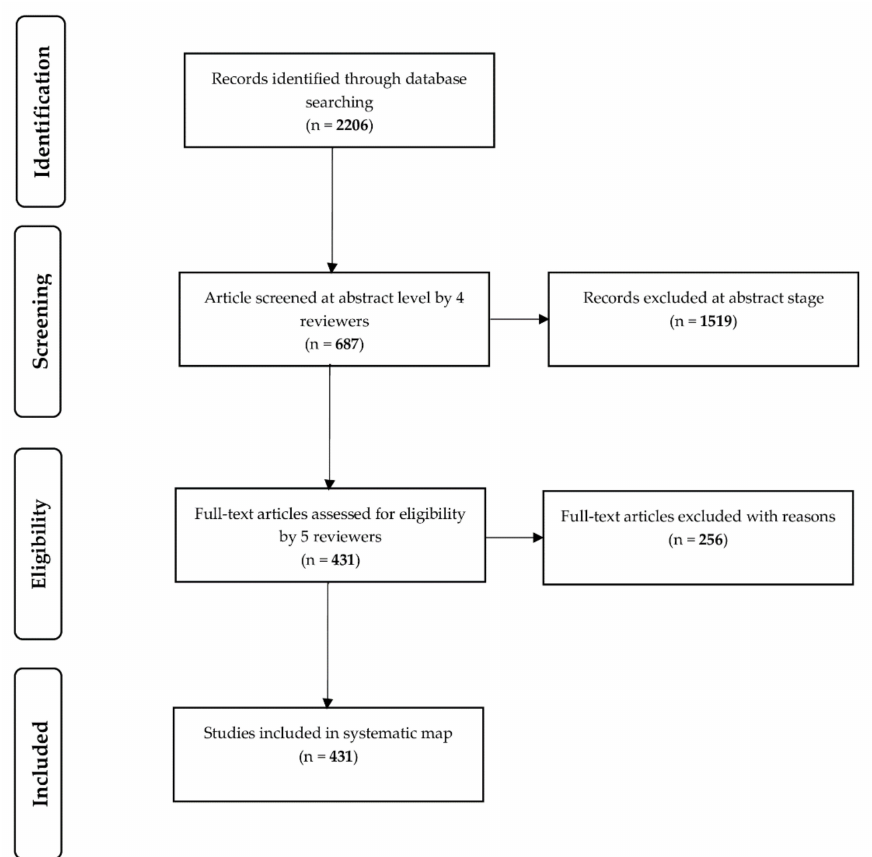
Figure 1. Systematic mapping process of the study, illustrating articles from the initial search to screening for synthesis (identification, screening, eligibility, and inclusion). Articles were found through database search at the identification stage. Then the articles captured were screened based on the categories of agroforestry practices, ecosystem services, and the Asia-Pacific region (through titles, keywords, abstracts, and full text articles) at the screening and eligibility stages. Finally, the articles satisfied with the eligibility criteria were included for the